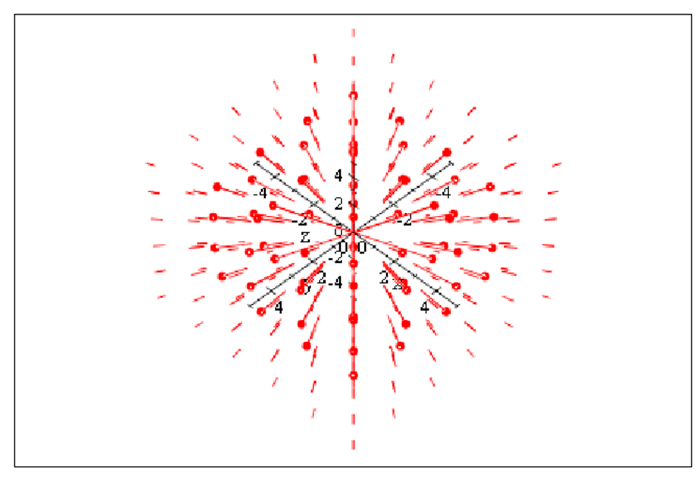
Figure 11. Vector field of catalyst fluid velocity, crude sample.